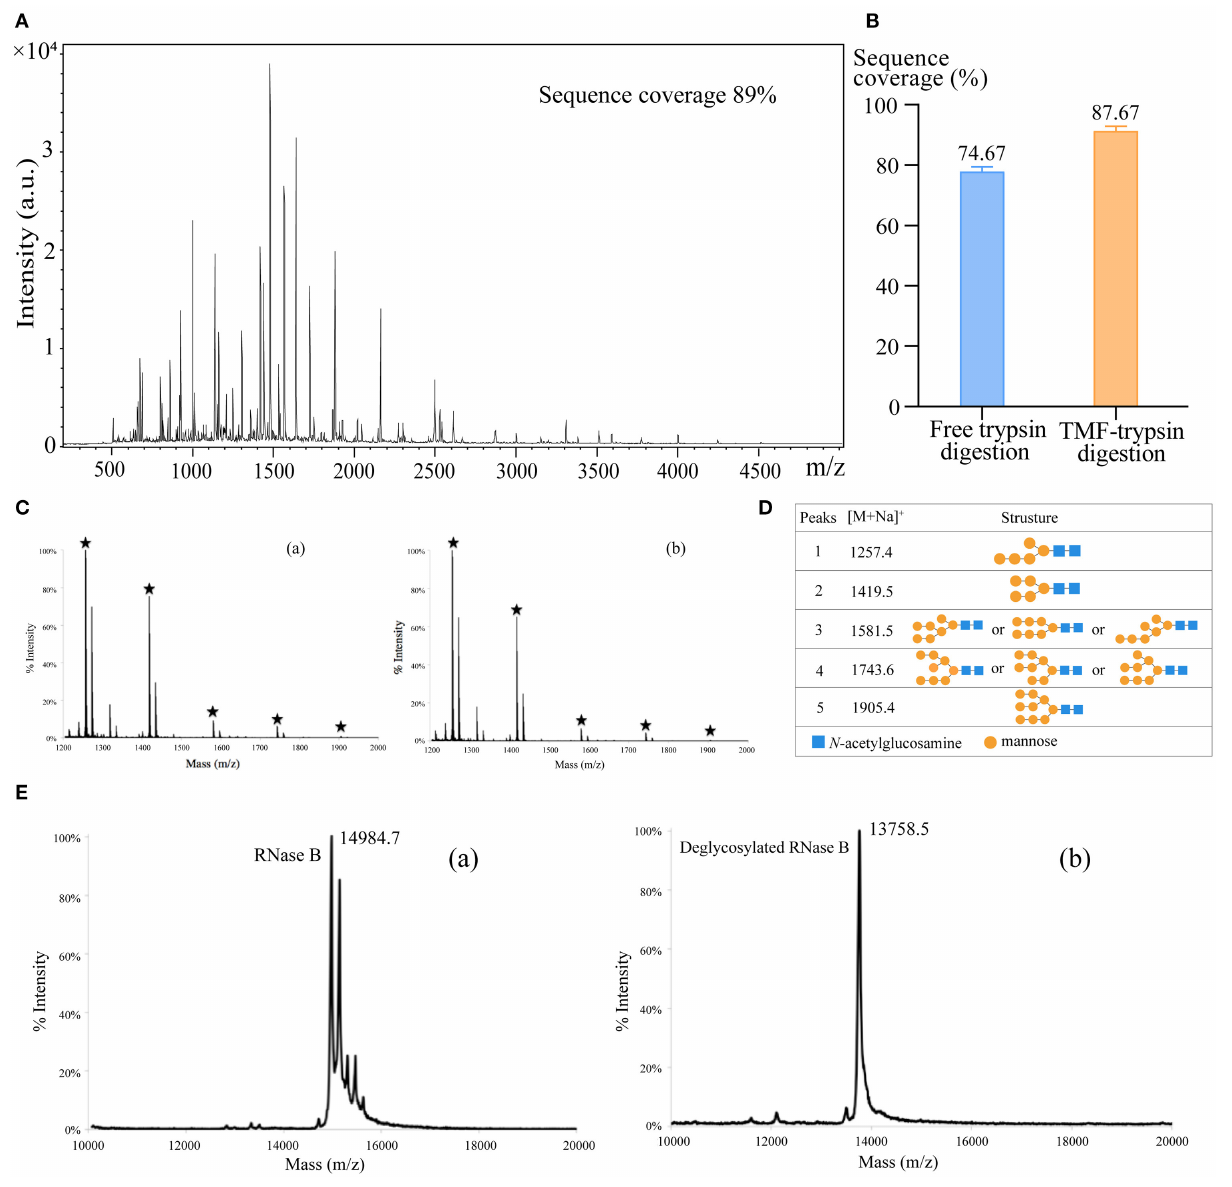
( Figure 1 ). After TMF–trypsin digestion of urine proteins, the peptides were subjected to N- glycopeptides enrichment by hydrophilic interaction liquid chromatography (HILIC) (Mysling et al., 2010; Cong et al., 2017). The N -glycopeptides are further subjected to deglycosylation with TMF–PNGase F in the H 18 O system. The 18 O-labeled N- glycopeptides 2 were collected for mass spectrometry analysis. With